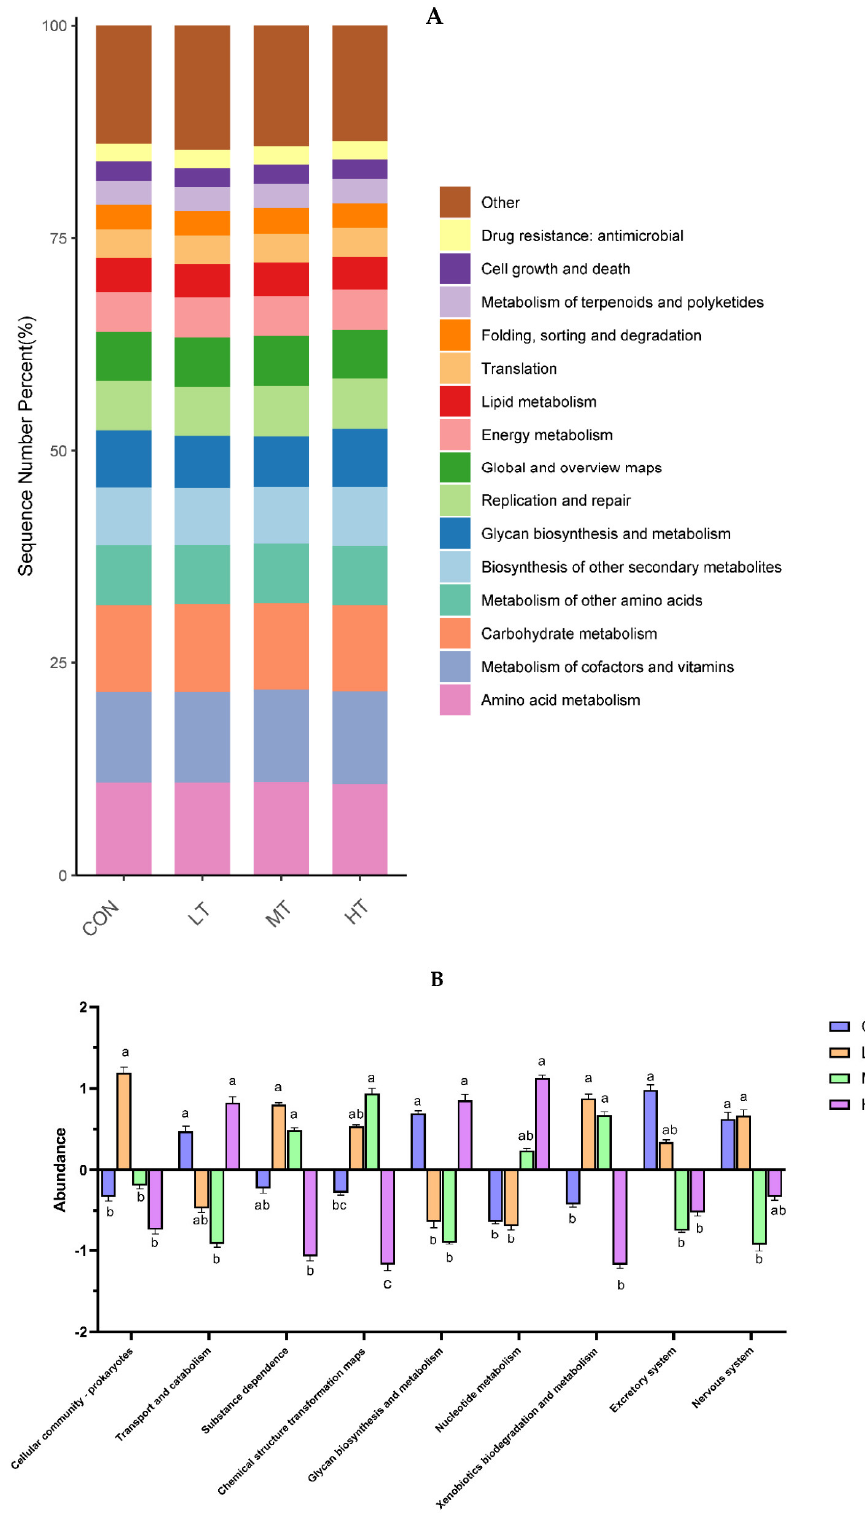
Figure 6. ( A ) Prediction of relative abundance of ruminal bacteria metabolic functions by Level 2 Kyoto Encyclopedia of Genes and Genomes (KEGG). ( B ) Functional differences of ruminal bacteria in four groups at KEGG-pathway level 2. The different letters are significantly different ( p < 0.05).